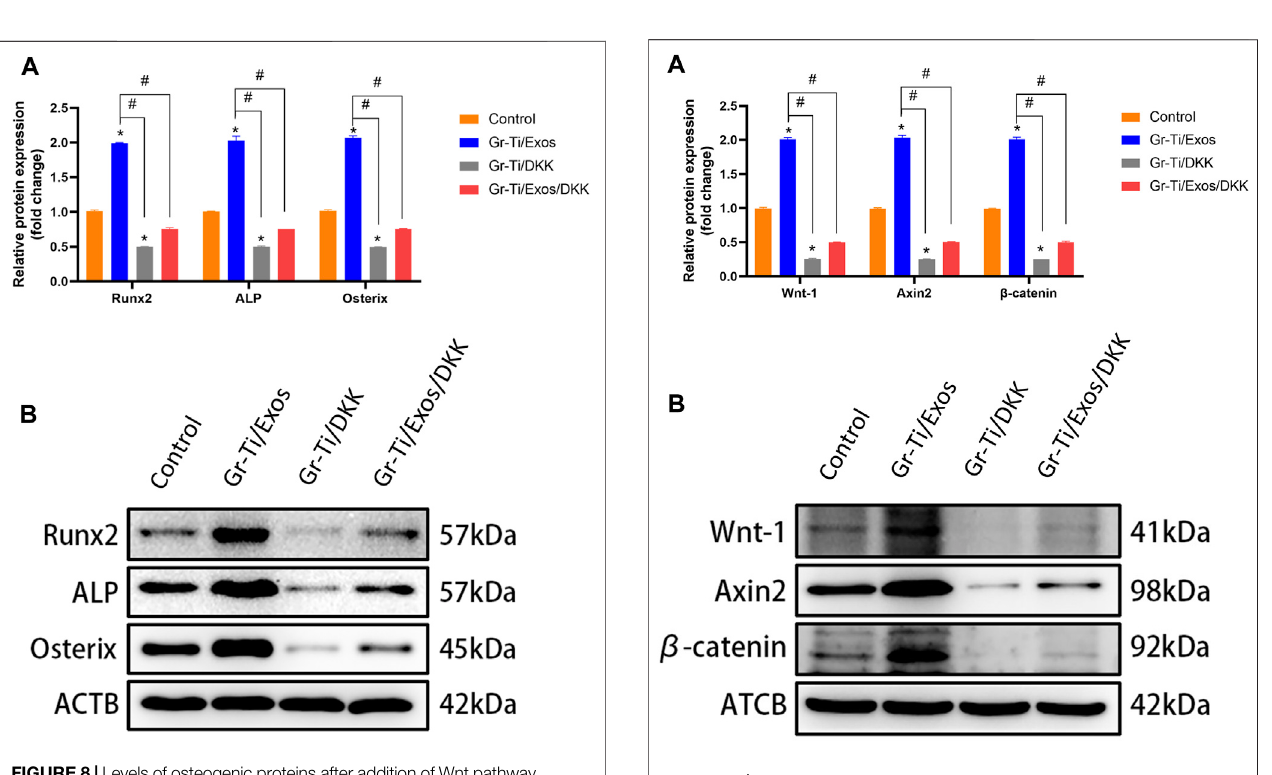
FIGURE 9 | KeyproteinsoftheWntpathwayafteradditionofWntpathway inhibitor DKK. (A) Relative intensity analyses of WB results; (B) The expression of protein analysed by WB. ( p represents statistical difference between control and other groups; # indicates statistical difference between Gr-Ti/Exos, Gr-Ti/ DKK, and Gr-Ti/Exos/DKK groups; p p < 0.05; # p <